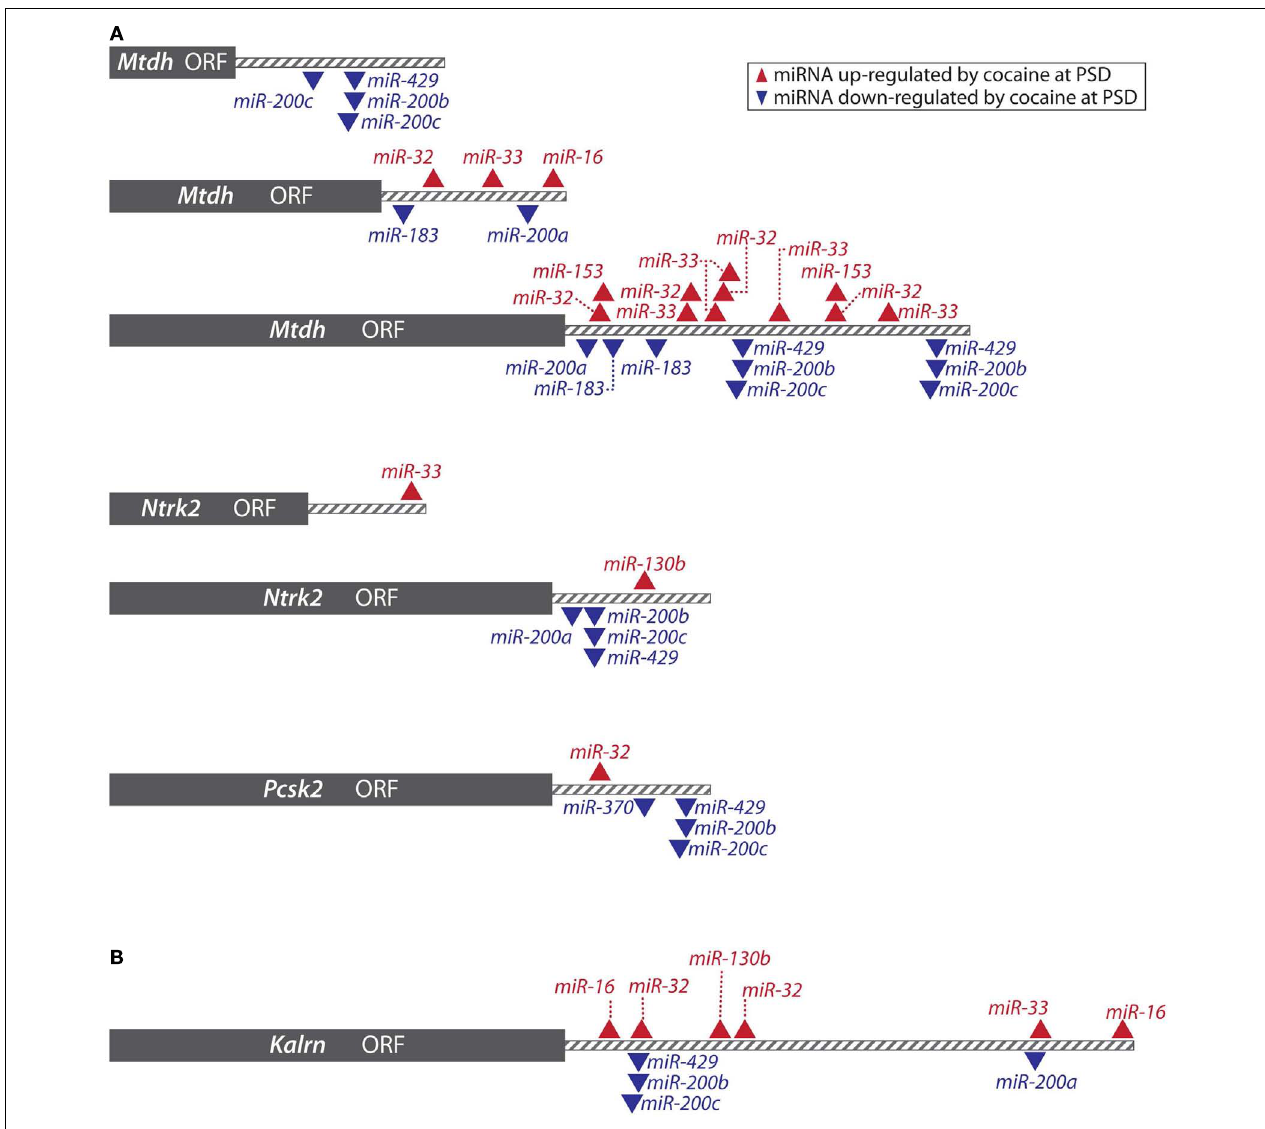
transcript; the 3 (cid:48) -UTR is shown by gray stripes; arrowheads indicate miRNA binding sites predicted for miRNAs up ( (cid:78) ) and down ( (cid:72) ) regulated by cocaine. Reproduced from Eipper-Mains et al. (2011) with permission. (B) Kalrn was included in the list of synaptically enriched transcripts targeted by cocaine-regulated PSD-enriched miRNAs. Shown are the miRanda predicted binding sites for the 16 most cocaine-regulated striatal PSD miRNAs in the 3 (cid:48) -UTR of mouse